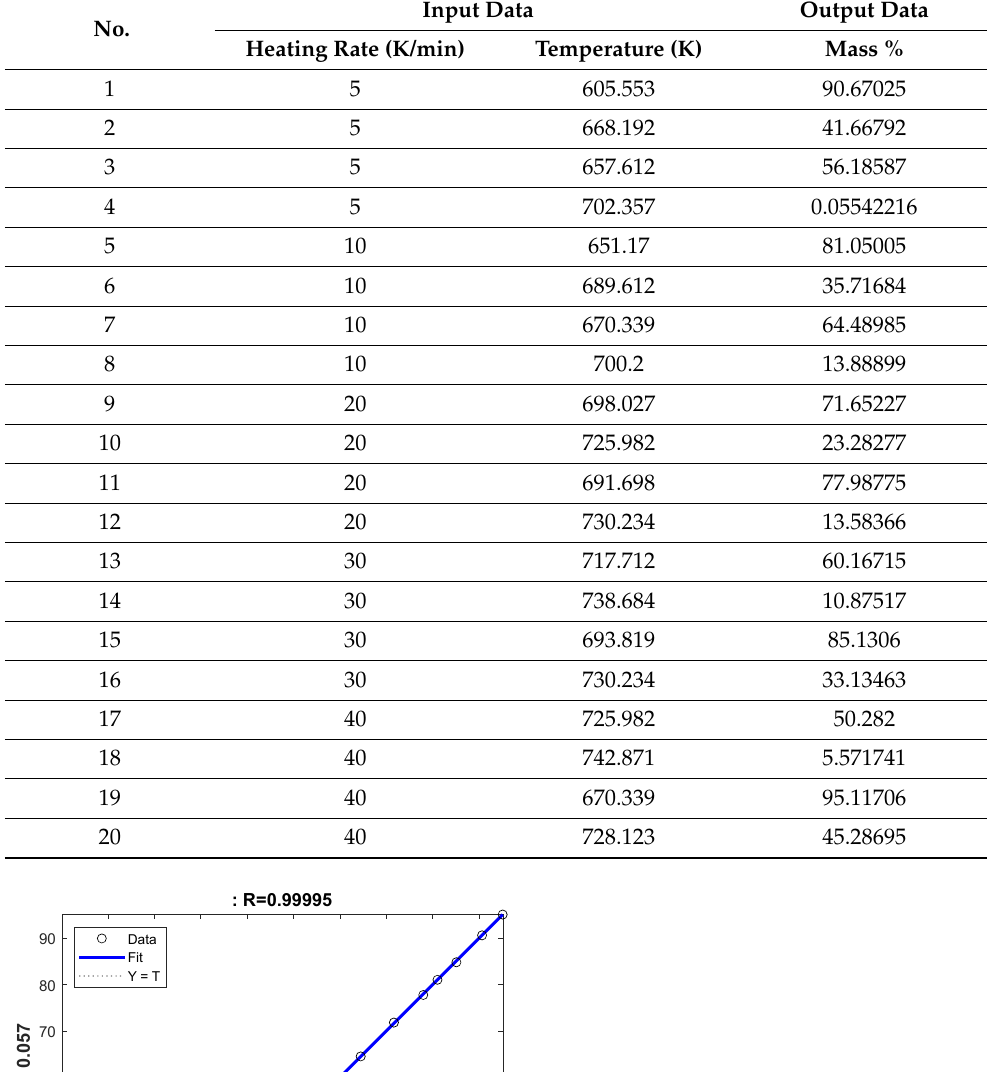
Table 3. Simulation data.